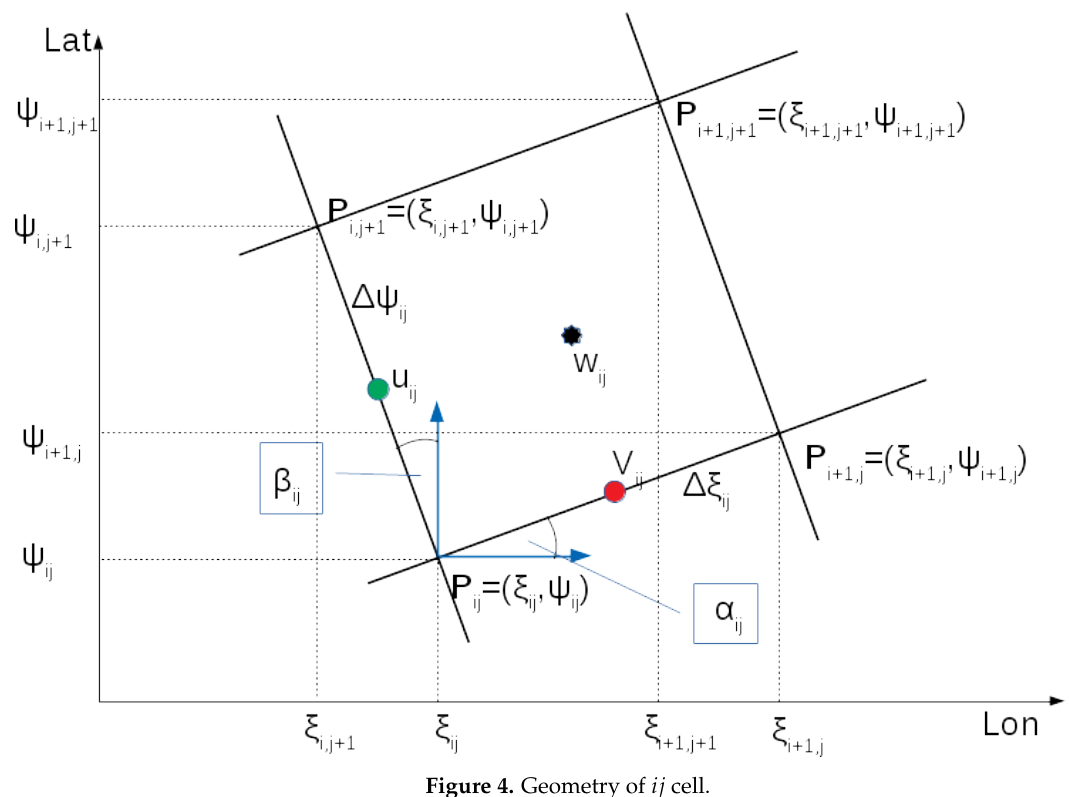
Figure 4. Geometry of ij